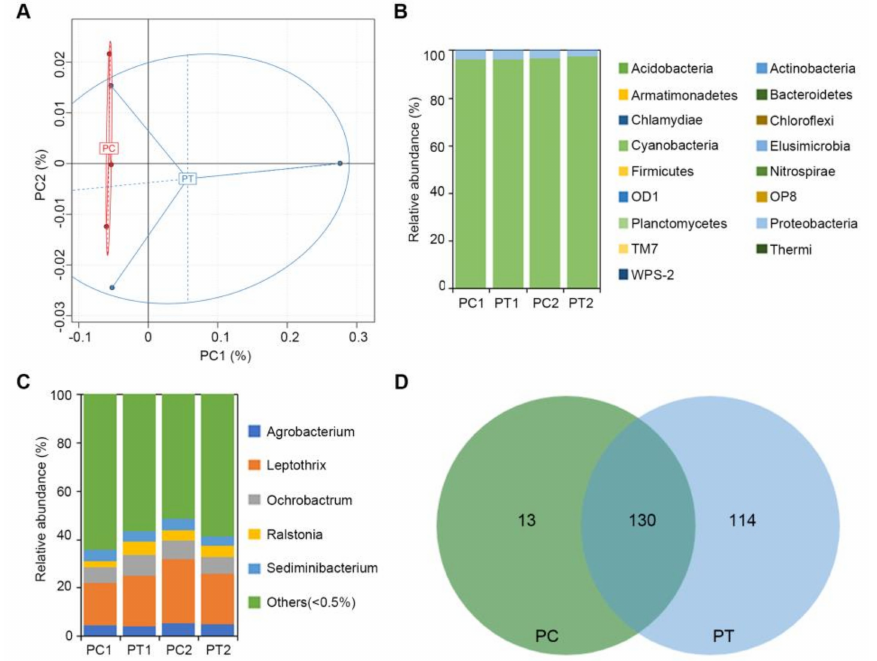
Figure 7. Characteristics of 16S sequencing data of potato samples. ( A ) Principal component analysis based on OTU abundance in bacteria. X-axis represents principal component 1 and Y-axis represents principal component 2. Numbers within parentheses represent contributions of principal components to differences among samples. Each dot represents an individual soil sample, and different colors represent different groups. ( B ) Relative abundances (percentage of sequences) of bacteria at the phylum level. ( C ) Relative abundances (percentage of sequences) of bacteria at the genus level. ( D ) Venn diagram of OTUs between PC and PT. PC refers to potatoes derived from the control treatment, and PT refers to potatoes derived from plots treated with Bacillus subtilis strain Bv17.